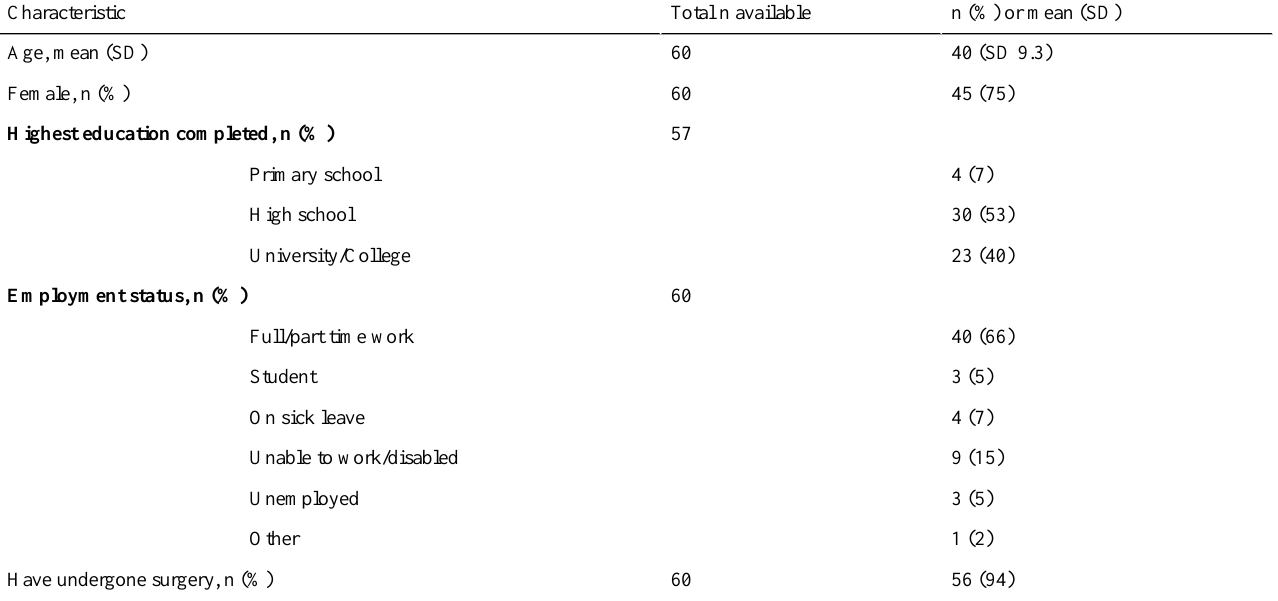
Table 1. Demographic data of the patients who had access to the discussion forum through the eHealth portal.